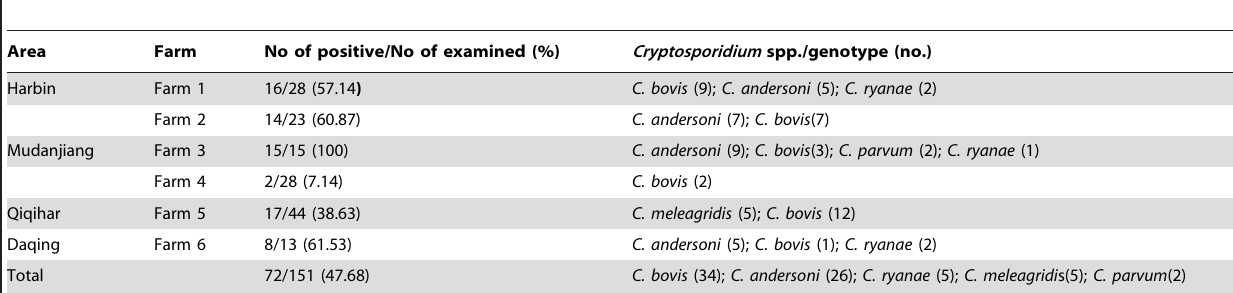
Table 1. Prevalence and distribution of Cryptosporidium spp. in pre-weaned calves in Heilongjiang Province, China by sequence analysis of the SSU rRNA gene.